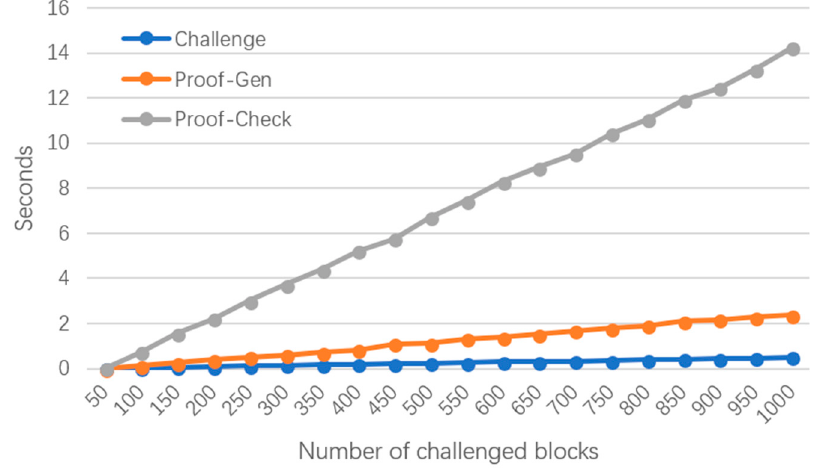
Figure 3. Tag generation time for increased number of data blocks.